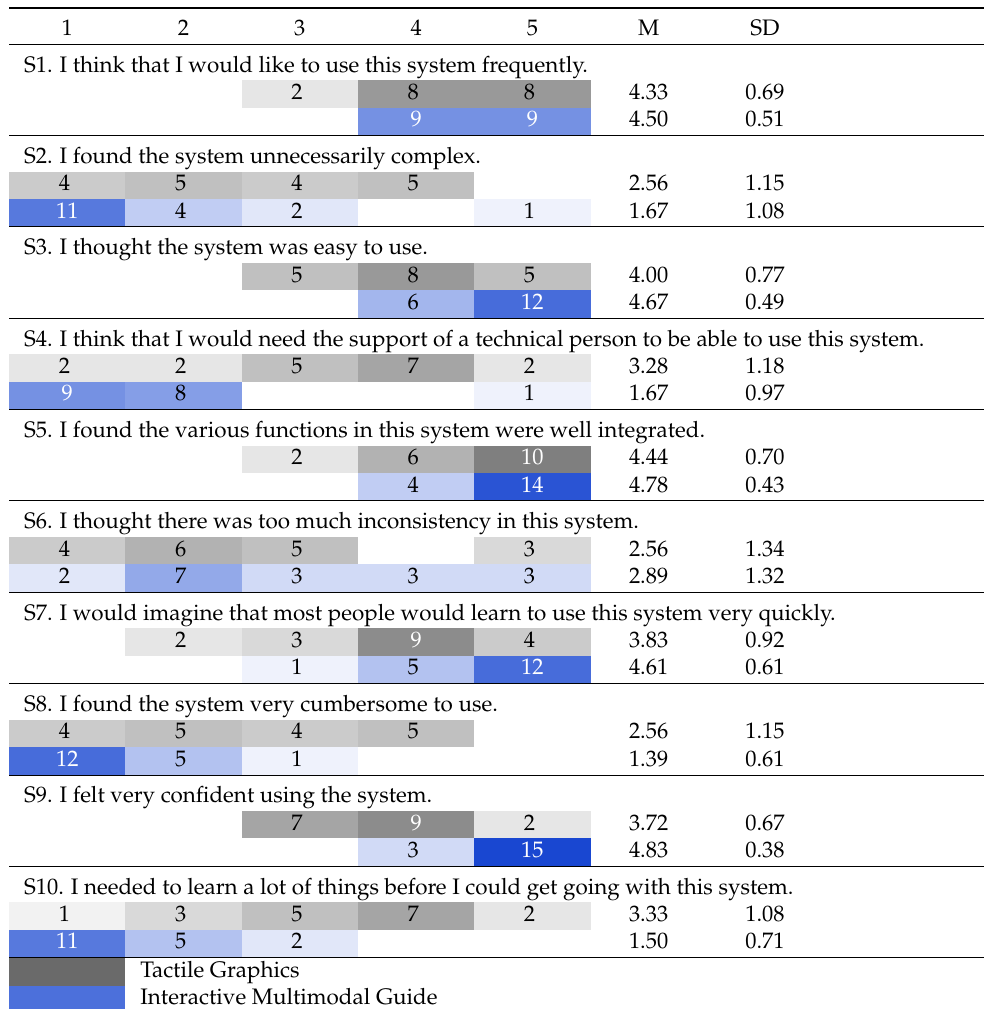
Table 4. Tactile Graphics and Interactive Mulitmodal Guide Exhibits Standard Usability Scale